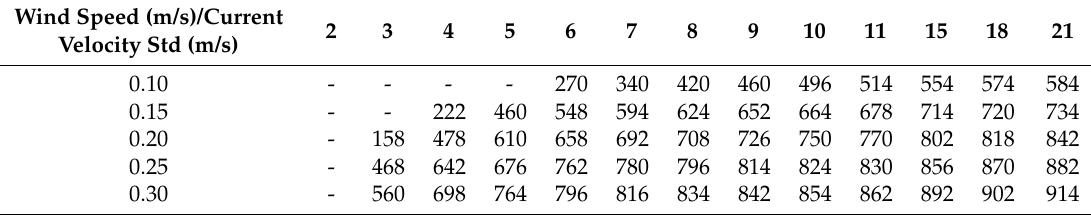
Table 7. Current field effective swaths of different current velocity Stds in different wind speeds. Wind Speed (m/s)/Current Velocity Std